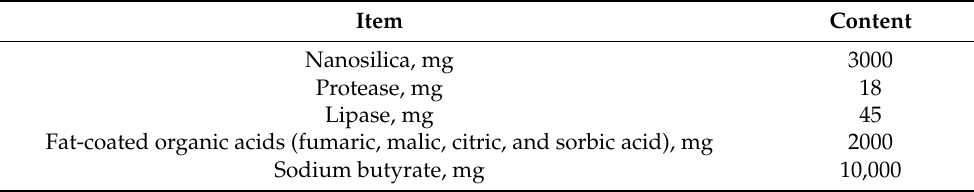
Table 1. Composition of one dose of the feed additive based on nanosilica.